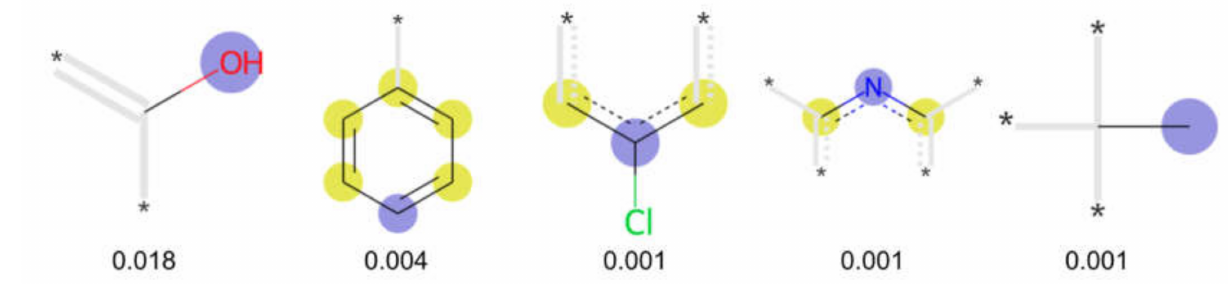
Figure 6. Examples of fingerprint features used by the regularized RF model. For each fingerprint bit, blue shades indicate the central atom, and yellow shades indicate aromatic environment atoms. The asterisk (*) denotes adjacent aliphatic or aromatic atoms. Feature importance values are noted below each